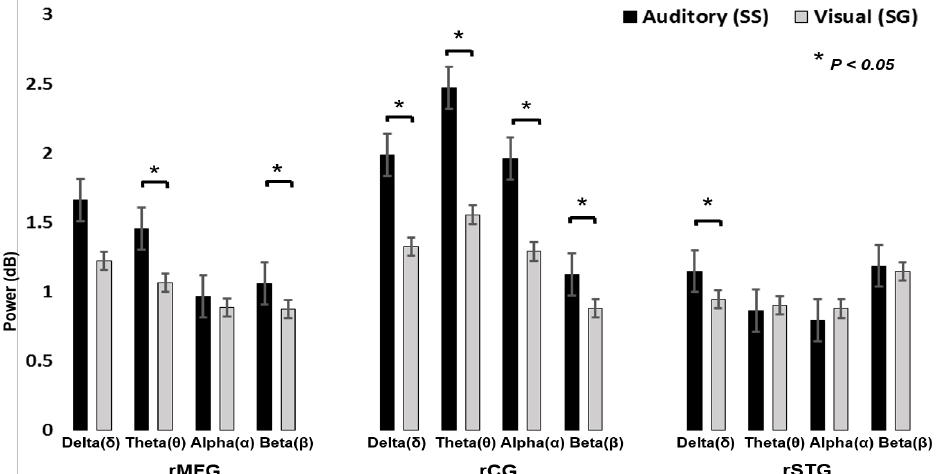
Figure 9. The comparison in absolute value of delta ( δ ), theta ( θ ), alpha ( α ), and beta ( β ) band powers and standard errors between visual stimuli and auditory alarms in rMFG, rCG, and rSTG during human inhibitory control. Asterisks show pairwise significance (* p < 0.05) in t-tests between the visual and auditory conditions.